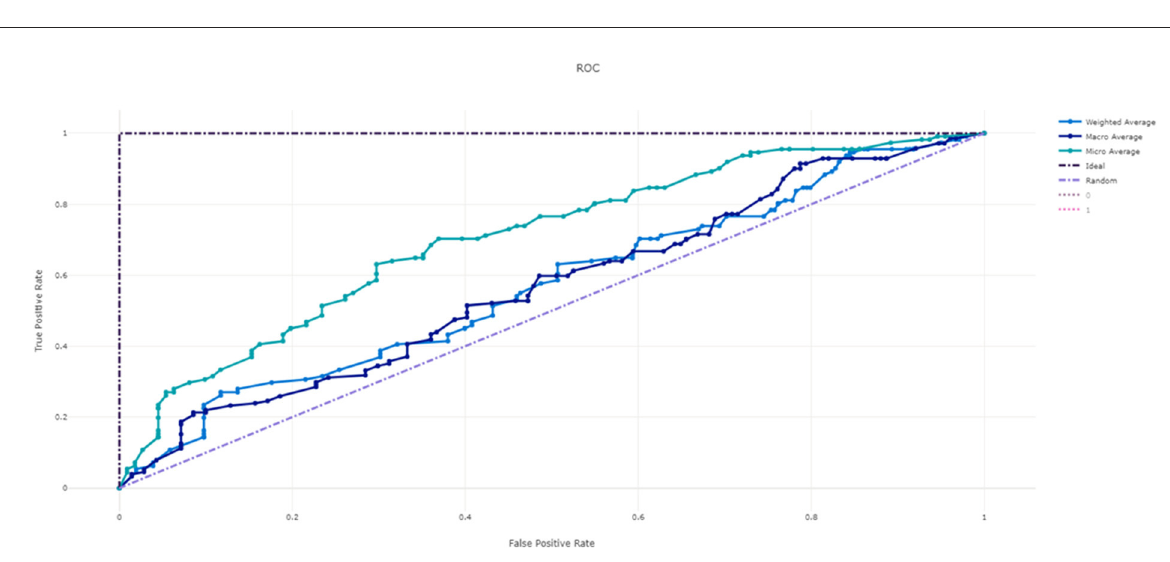
FIGURE6 ROC curve of Logistic Regression model predicting fall risk among hospitalized